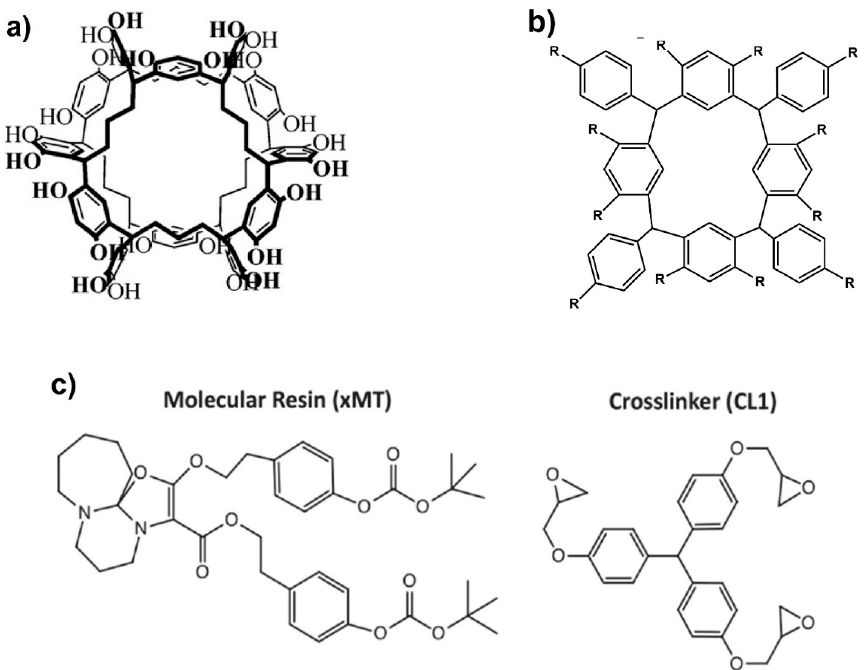
Figure 7. Examples of di ff erent cores for molecular glass resists that have been used for EUV lithography. ( a ) Noria molecule introduced in [85], graph adapted from [85], with permission from John Wiley & Sons, 2020, ( b ) a generic calixarene structure that has been the basis of a number of resist formulations and ( c ) basic components of a multi-triggered resist i.e., a molecular resin and a crosslinker, adapted from [83], with permission from The Society of Photopolymer Science and Technology,